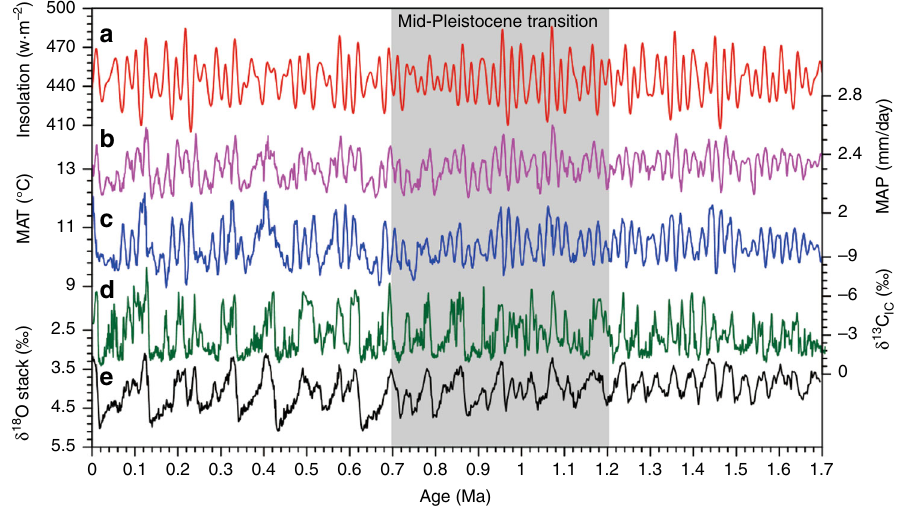
Fig. 6 Variations of proxy data and model results over the past 1.7 Ma. a Summer insolation at 65°N 55 . b Simulated mean annual precipitation (MAP) and c mean annual temperature (MAT) over the northern China. d JY loess δ 13 C IC record. e Benthic δ 18 O stack 3 . The gray bar denotes the mid-Pleistocene transition